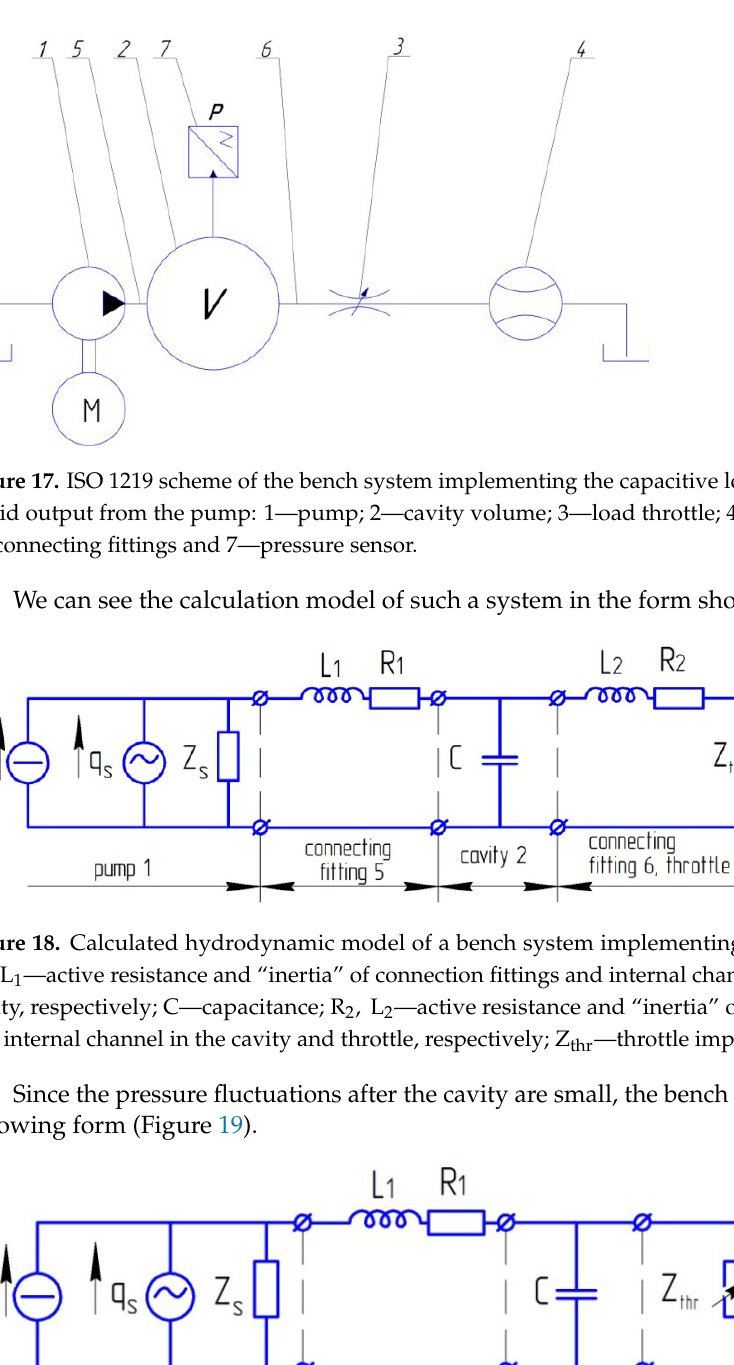
Figure 19. Calculated hydrodynamic model of the bench system implementing the capacitive load. The input impedance of the bench system including the connecting fittings Z b . s .